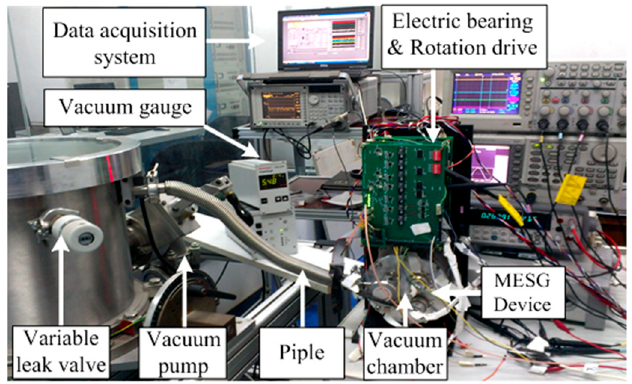
Figure 9. The MESG setup to test the decoupling compensation performance of the gyro rebalance loop.